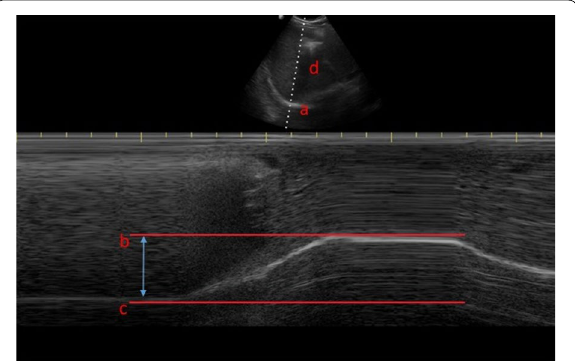
Fig. 2 Diaphragm excursion as assessed via M-mode ultrasonography, where a is the diaphragm, b is at the end of a deep inspiratory effort, c is at end expiration and d is the